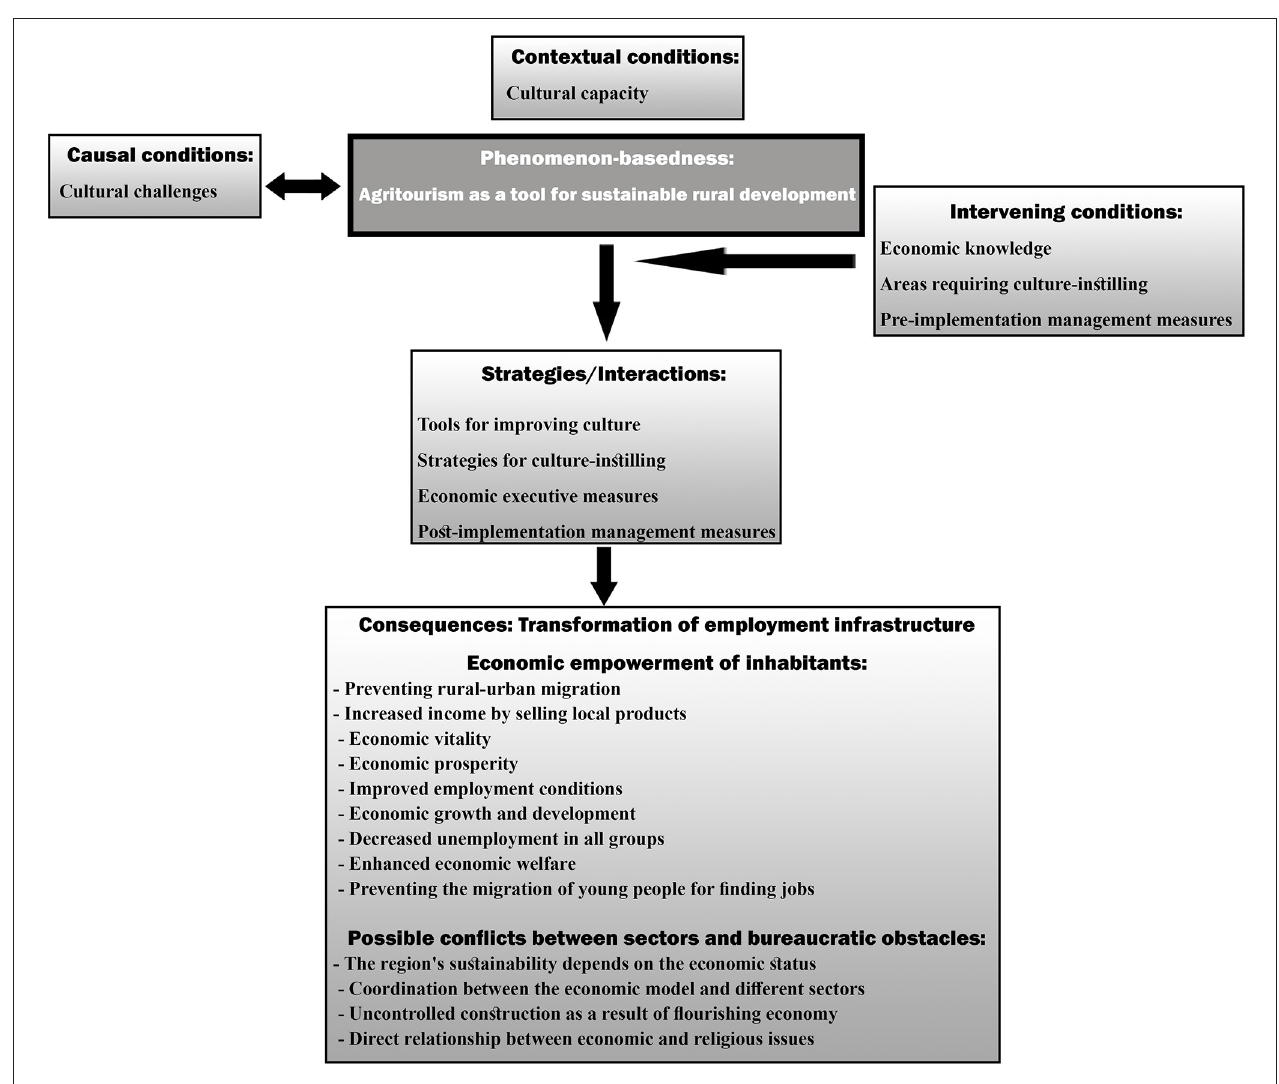
FIGURE 2 | The theoretical model of the research